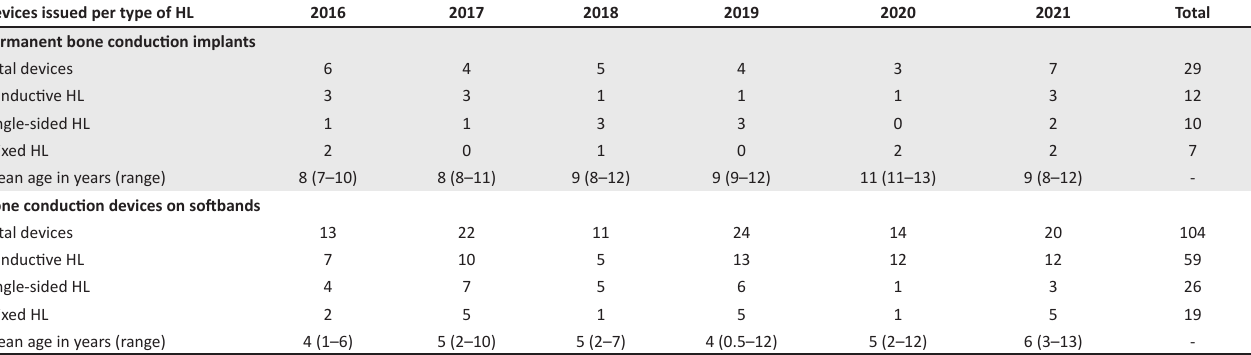
TABLE 1: Profile of patients fitted with implanted and softband bone conduction devices at Red Cross War Memorial Children’s Hospital from 2016 to 2021. Devices issued per type of